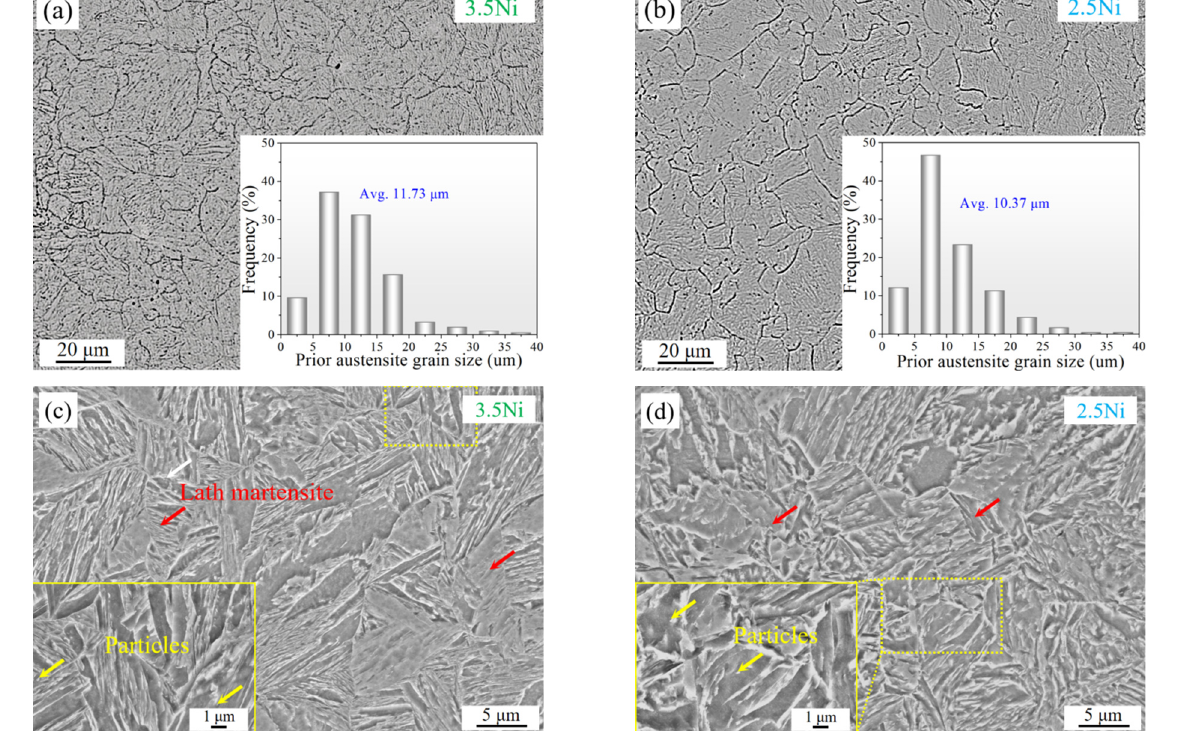
Figure 2. ( a , b ) OM micrographs of PAG and ( c , d ) typical SEM micrographs of matrix for the quenched 3.5 Ni and 2.5 Ni steels. Inserted graphs in ( a , b ) show the distribution curves of the size of PAG.